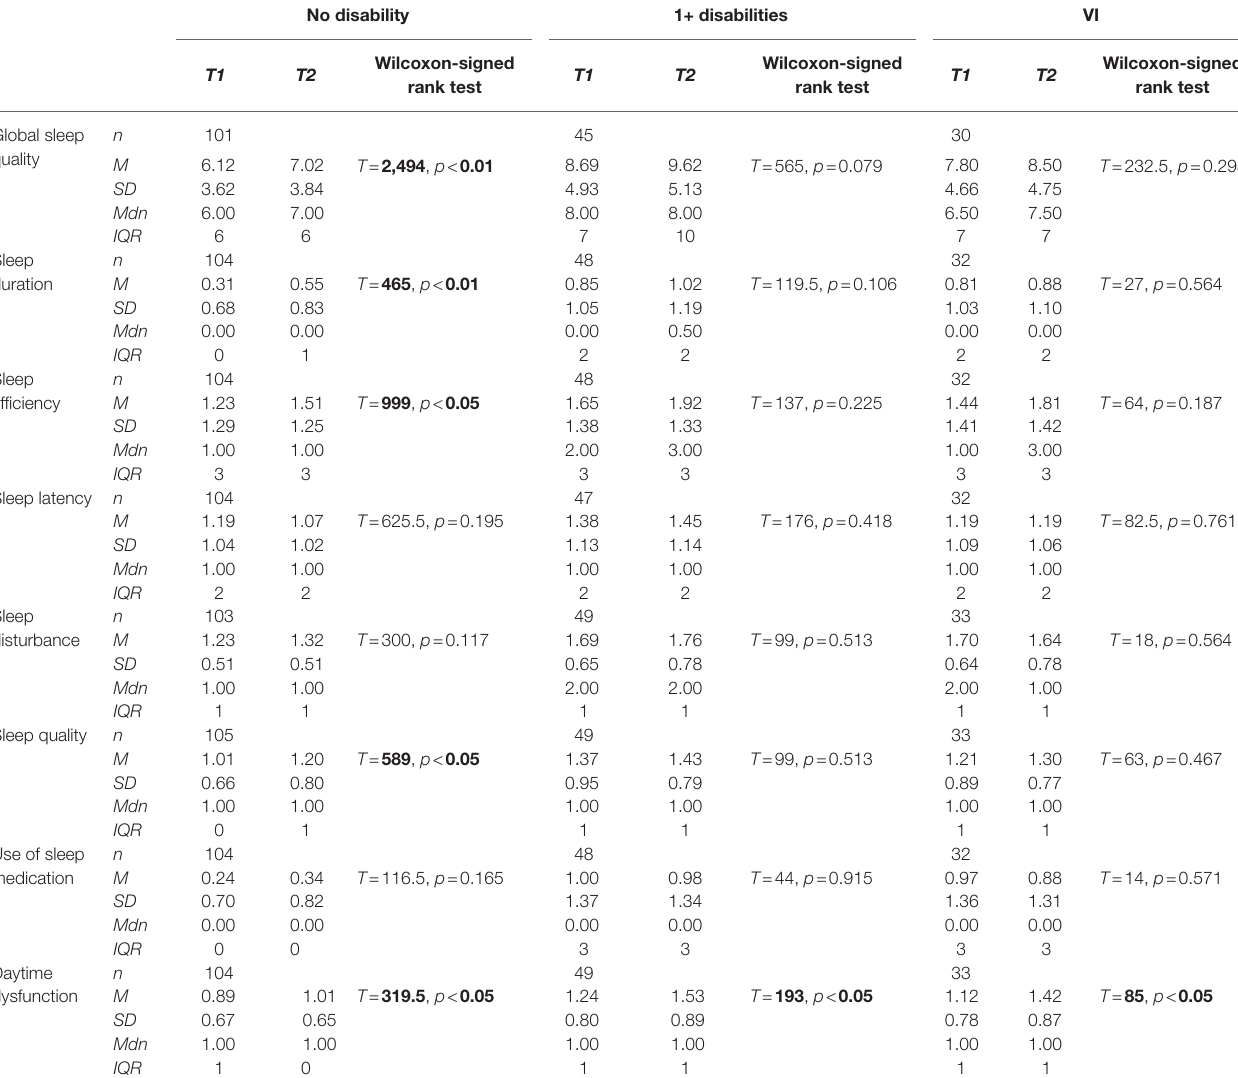
TABLE 5 | Within-group comparison of T1 and T2 PSQI global and component scores by subgroup. No disability 1+